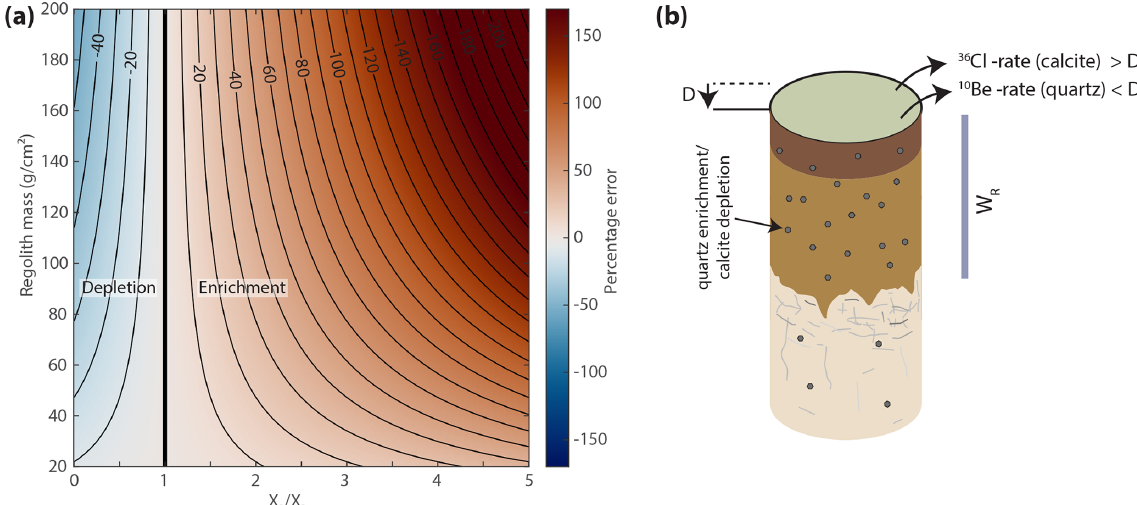
Figure 5. (a) The percentage change in 10 Be concentration compared to a no-weathering case for different regolith masses and ratios of (cid:16) X (cid:17) R regolith and bedrock mineral fractions at sea level high latitude (SLHL). (b) Conceptual representation of a rock with carbonate and X B quartz minerals experiencing regolith weathering. The quartz grains would be enriched in the regolith compared to the calcite. Therefore, a 10 Be denudation rate computed from quartz without correction would be lower than the average denudation rate, whereas a 36 Cl denudation rate measured from calcite would be